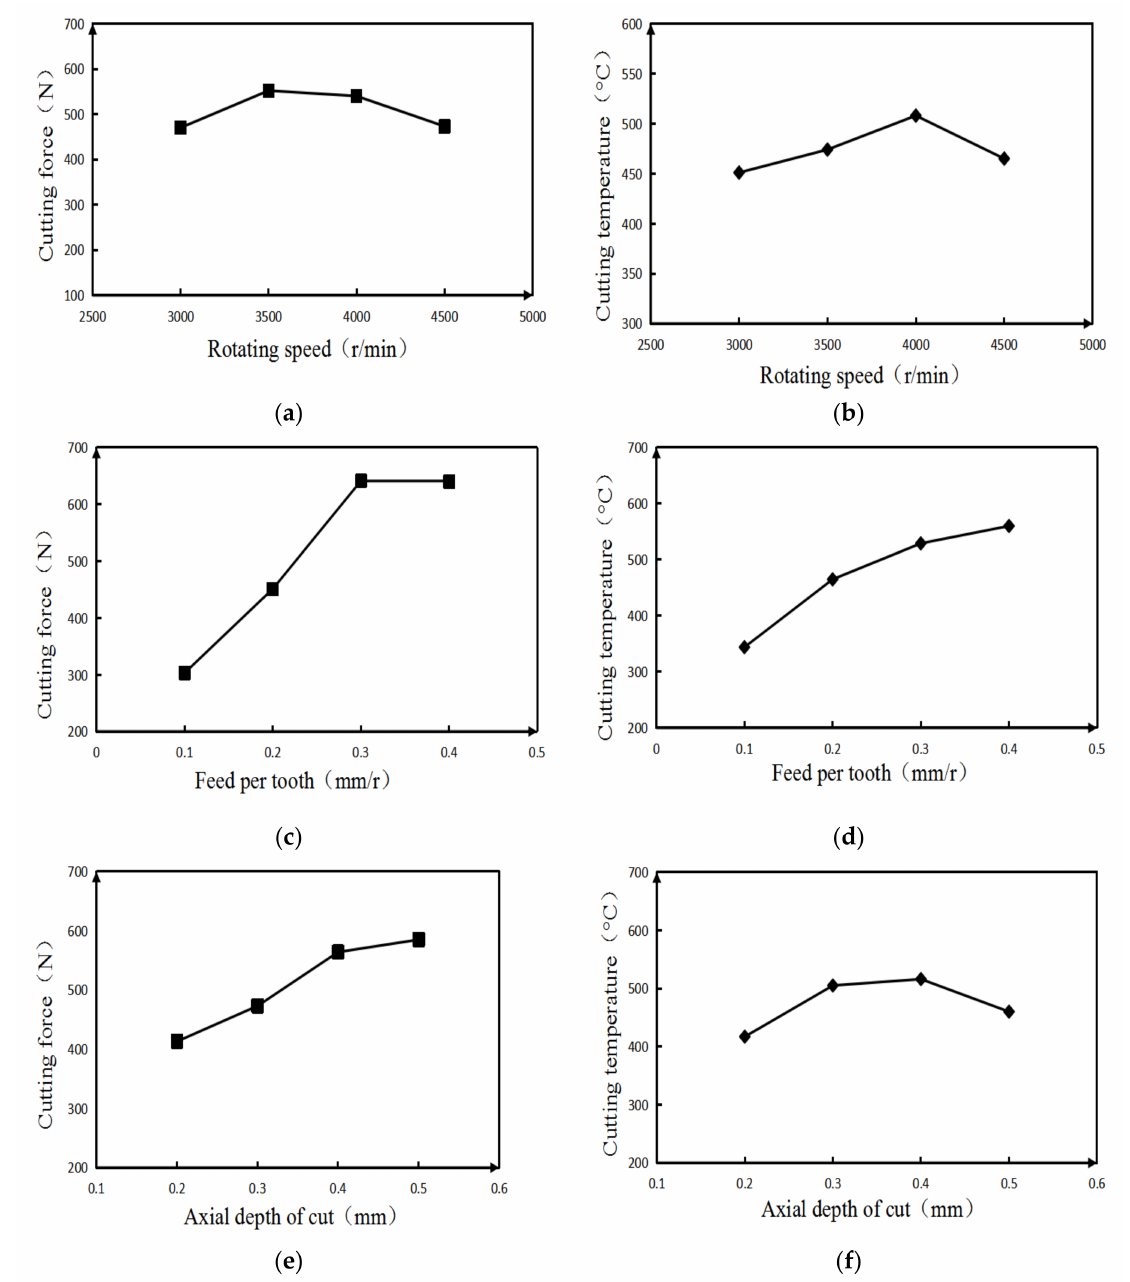
Figure 2. Trend chart of indicator factors. ( a ) The influence of spindle speed. ( b ) The influence of spindle speedon cutting forceon cutting temperature. ( c ) The influence of feed per tooth. ( d ) The influence of feed per tooth on cutting forceon cutting temperature. ( e ) Influence of axial depth of cut. ( f ) Influence of axial depth of cut on cutting forceon cutting